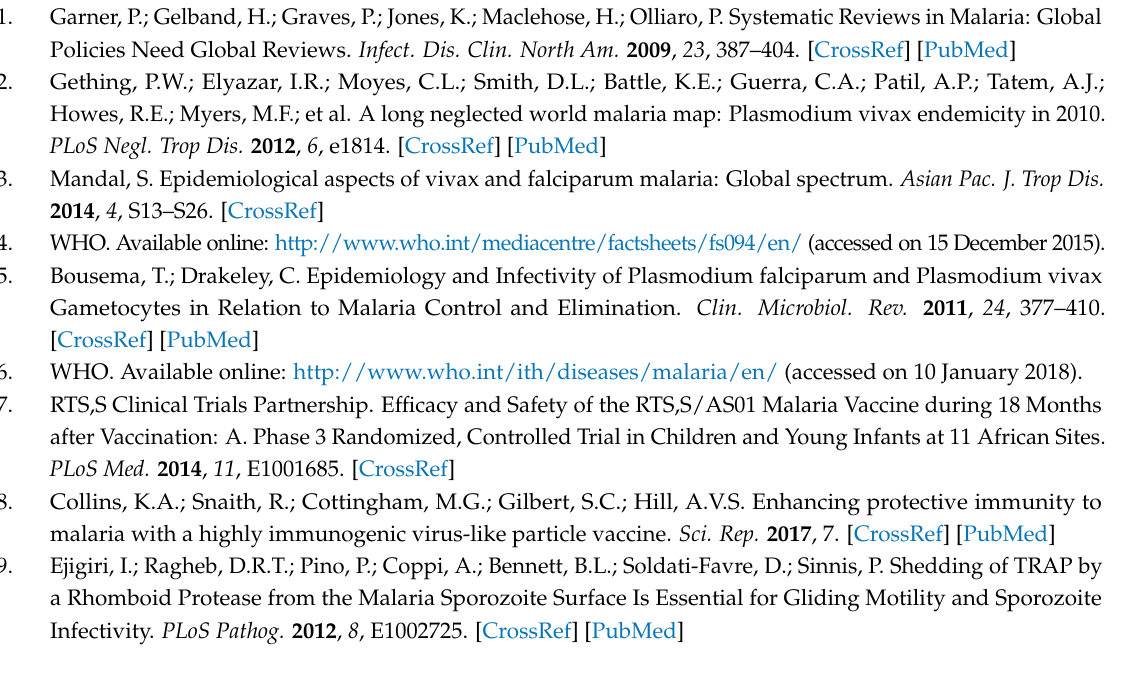
Figure S1: Strategy to generate a chimeric P. berghei parasite line expressing P. falciparum TRAP. Figure S2. Genotype analyses of the chimeric P. berghei parasite line expressing P. falciparum TRAP. Figure S3. Phenotype analyses and fitness of the chimeric P. berghei parasite line expressing P. falciparum TRAP. Figure S4. In vivo imaging. Table S1. Primers for genotyping the transgenic parasite line. Table S2. Primers for generation of DNA construct. Table S3. Oocyst and sporozoites production for PfTRAP(r) PbTRAP transgenic parasite (line 2632 cl1) in comparison to the WT-GFP: Luc P. berghei (line 676m1